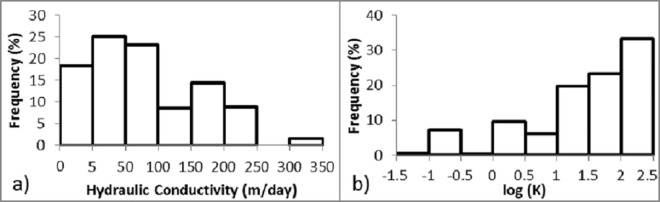
Frequency distribution of calibrated hydraulic conductivity.(a) Calibrated hydraulic conductivity is positively skewed; and (b) Logarithmic hydraulic conductivity log(K) is negatively skewed.